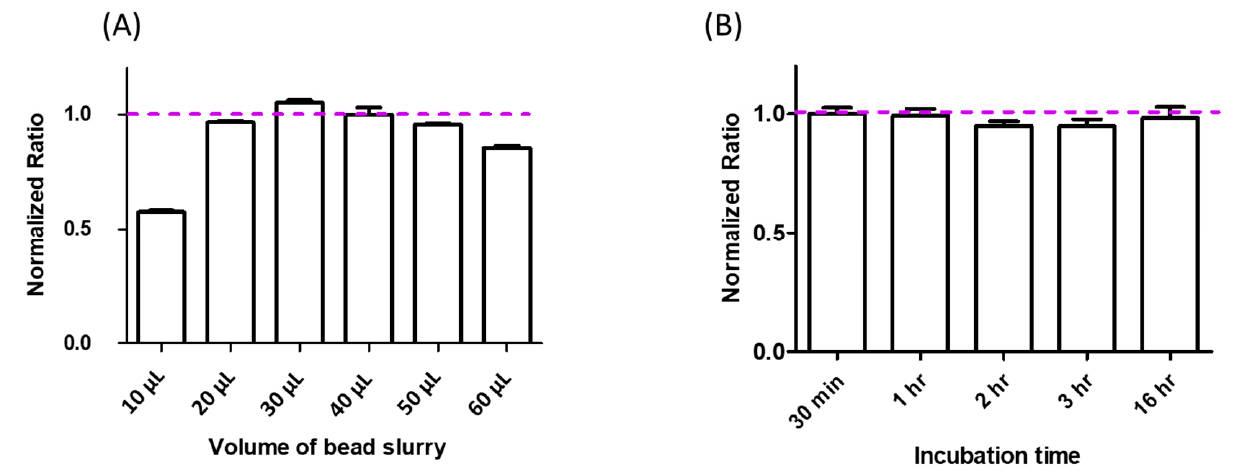
Figure 1. Results of the optimized volume of IgG4 affinity bead slurry and sample incubation time. Peak area of IgG4 surrogate peptide was used for comparison among different conditions. ( A ) Results of the volume of bead slurry used for IgG4 purification. The peak area from the 40 µL condition was used as the denominator for normalization, which was indicated as normalized ratio 1 with a pink dash line. ( B ) Incubation time for IgG4 purification. The peak area from the 30 min condition was used as the denominator for normalization. The standard deviation was calculated from technical replicates ( n = 3).